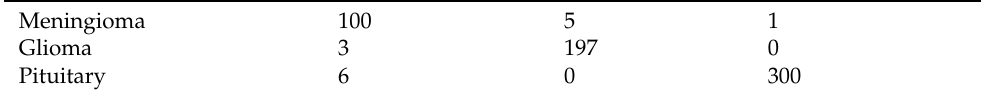
Table 2. Confusion matrix of three classes’